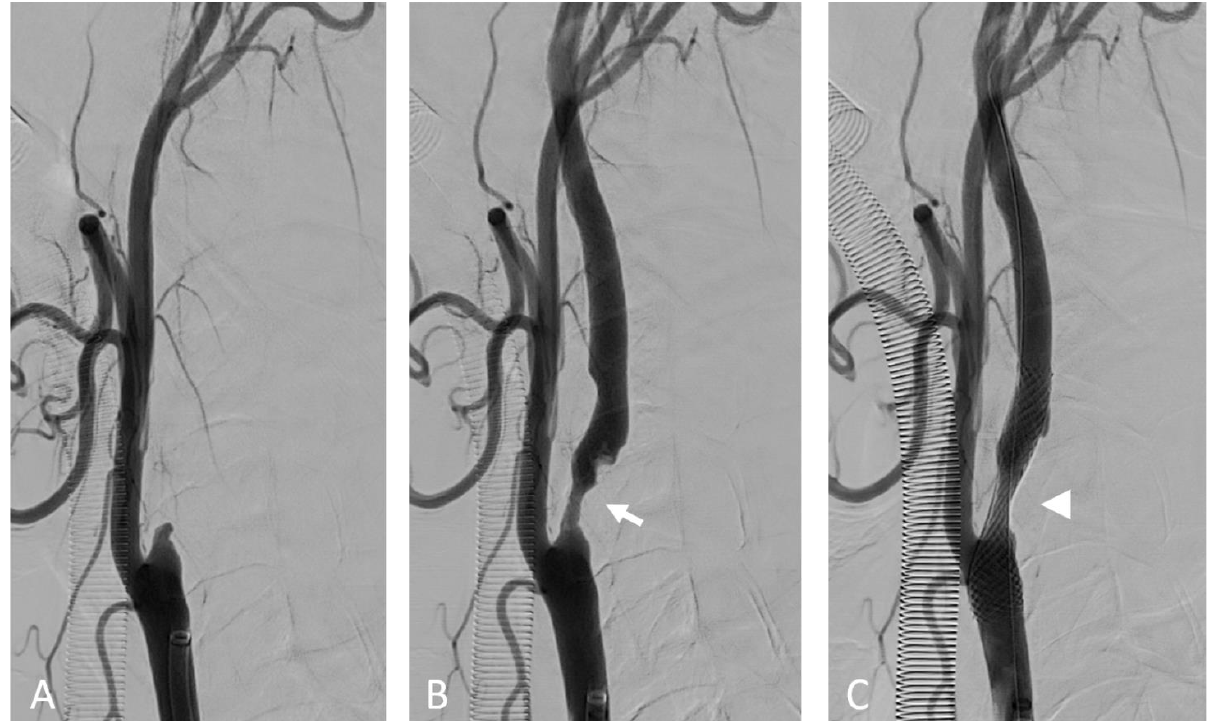
Figure 4. Internal carotid artery occlusion, digital subtraction angiography: acute thrombotic occlusion of the left internal carotid artery ( A ) causing sudden neurologic deficit in a 77-year-old patient. The serigraphy performed after mechanical thrombectomy and recanalization of the artery ( B ) highlights an ulcerated atherosclerotic plaque of the carotid bulb (arrow). After the administration of intravenous boluses of antiplatelet agents and heparin, a self-expanding stent (arrow) was placed in correspondence to the ulcerated plaque ( C ).